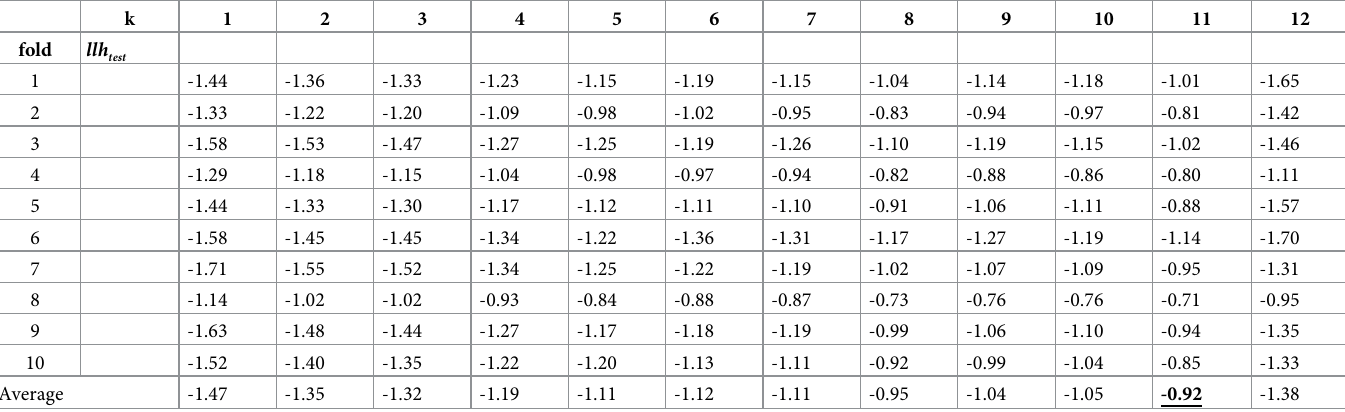
Table 2. 10-fold cross-validation on the parameter k . The optimal k that achieves the maximum complete data log-likelihood on the test set is k ¼ 11 . The unit of the test-dataset log-likelihood in the table is 10 4